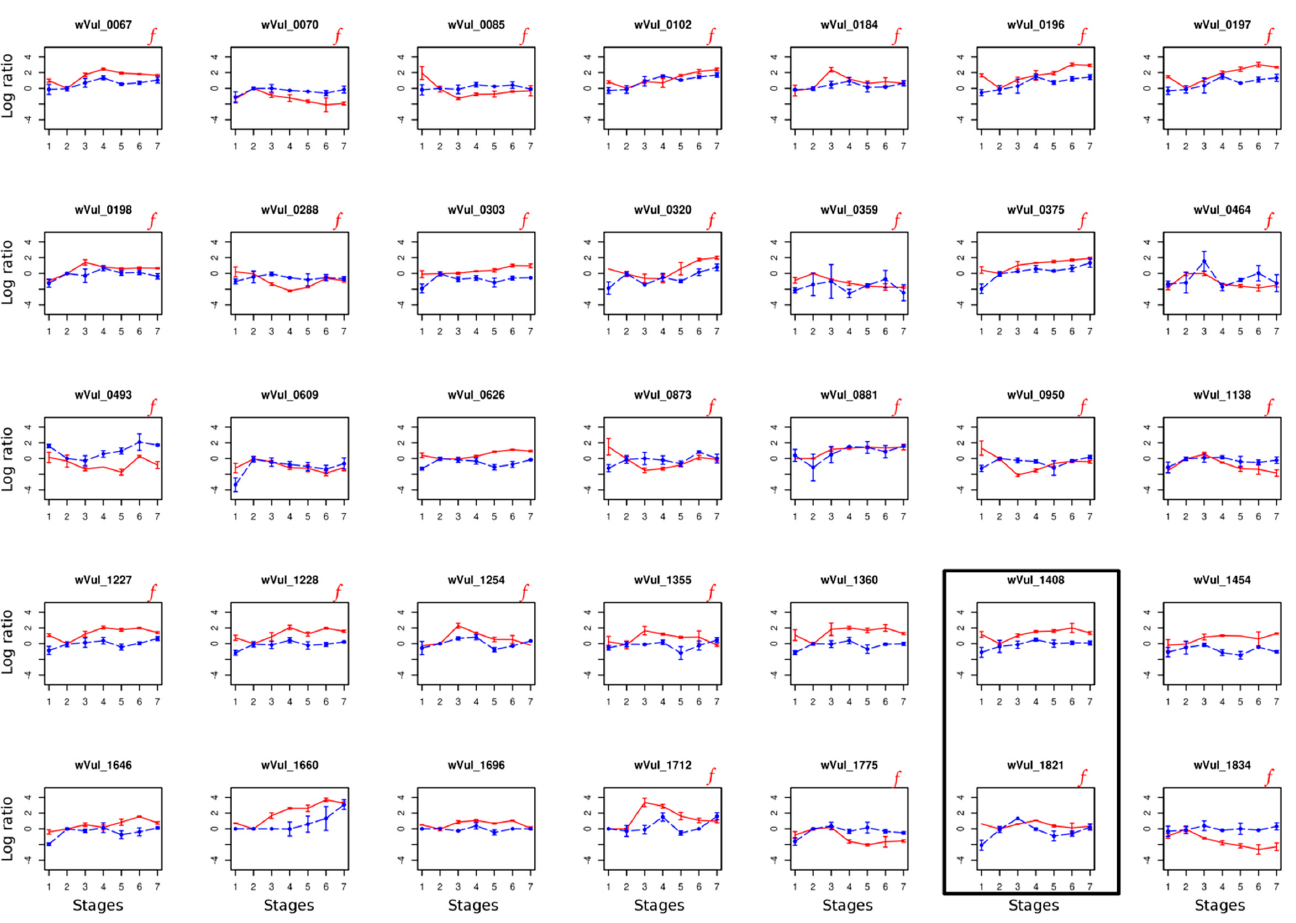
Figure 2. Candidate gene log2 expression of 35 candidate genes during both homologous and heterologous host development ( A. vulgare in red and C. convexus in blue, respectively). All candidate genes are consistently over- or under-expressed during native host development (in A. vulgare ). All genes present in the f element are labeled with a red “ f ”. The two genes showing a significant cross-correlation with exactly one-stage shift between the two hosts are boxed.